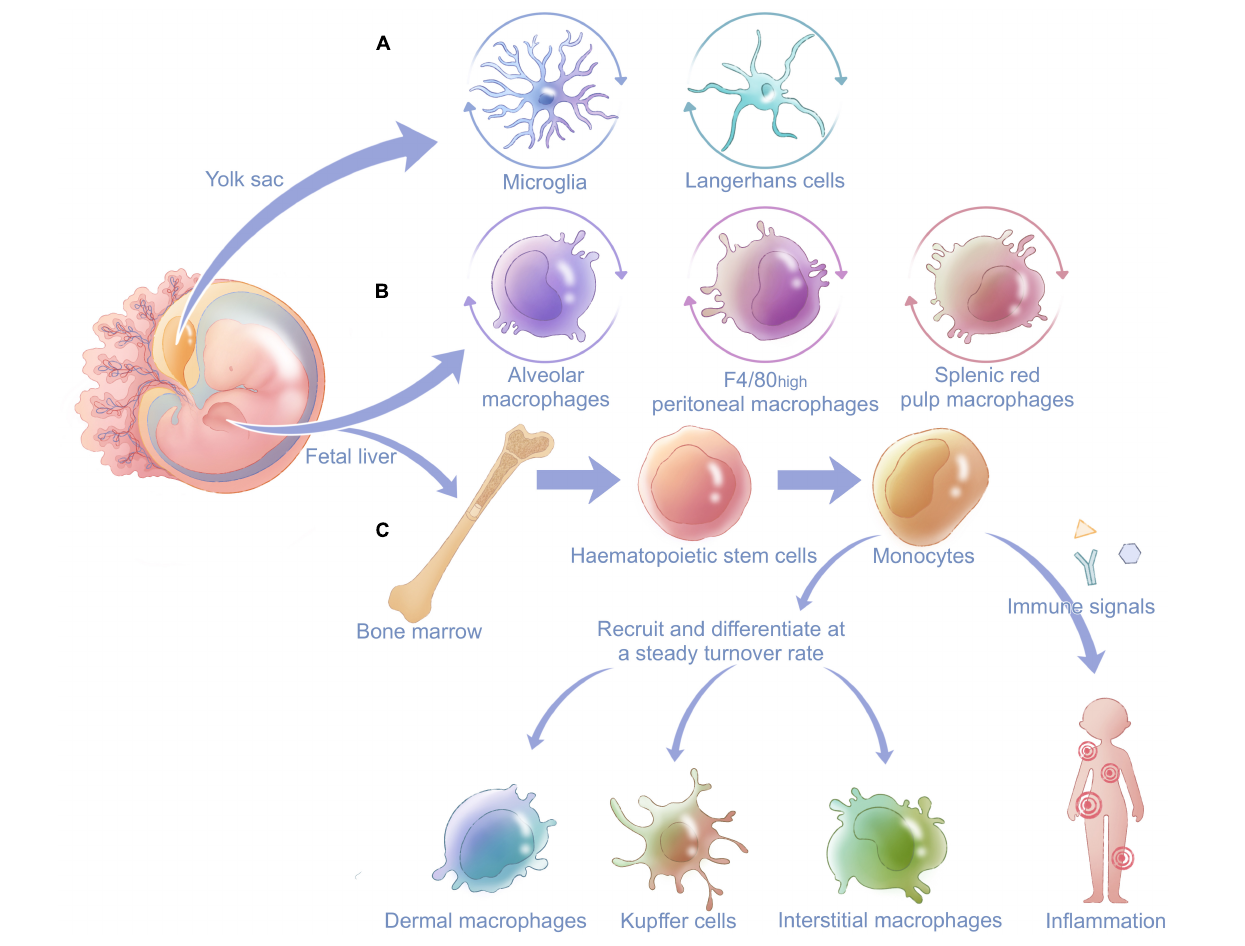
FIGURE 1 | General derivation and distribution of macrophages in the body. Macrophages are derived from two main fetal organs: the fetal liver and yolk sac. (A) Microglia in the central neural system and Langerhans cells in epidermal tissue have prenatal origins from the yolk sac and renew themselves locally after being seeded in different systems. (B) Alveolar macrophages, F4/80 high peritoneal macrophages, and splenic red pulp macrophages originate from the fetal liver and also have postnatal self-renewal capacity. Fetal liver gives rise to hematopoietic stem cells in bone marrow. (C) Hematopoietic stem cells can develop into monocytes and finally differentiate into other tissue-resident macrophages such as dermal macrophages, Kupffer cells, and interstitial macrophages after birth. When stimulated by immune signals, monocytes can be recruited and differentiate into macrophages at inflammatory sites and innate